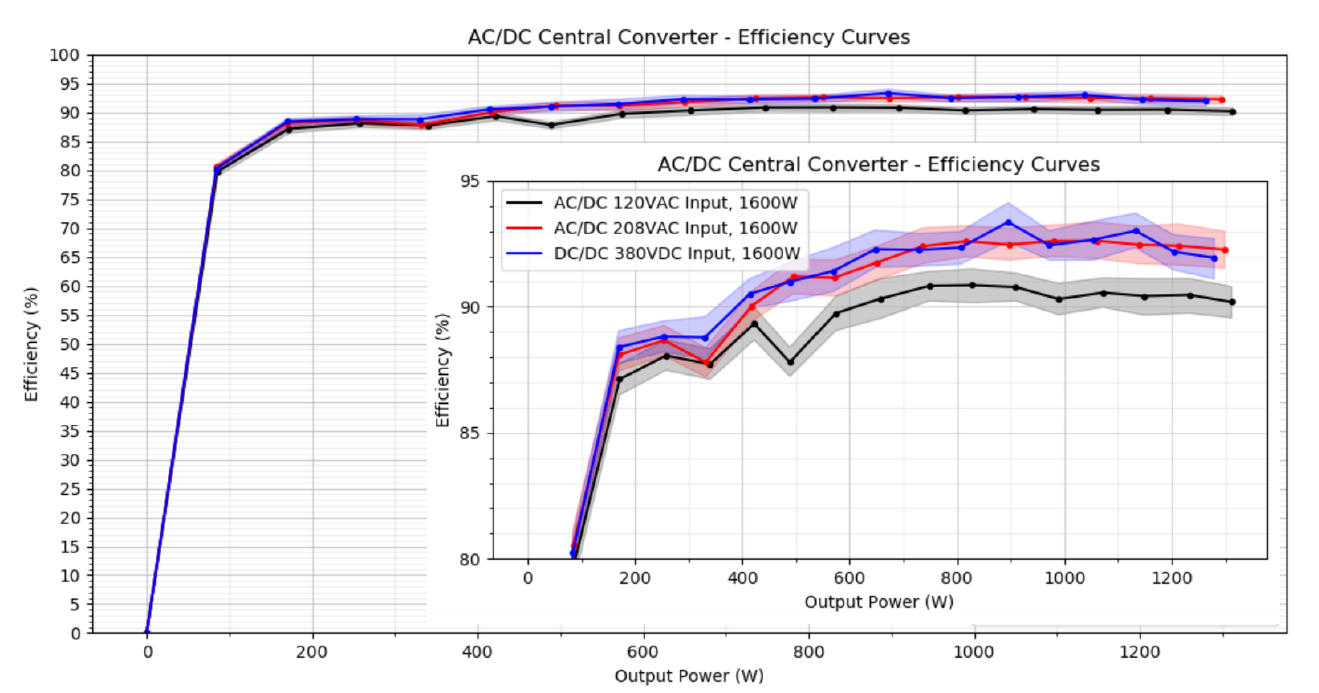
Figure 10. CC Efficiency curves at 120 V AC , 208 V AC , and 380 V DC , with respective uncertainties. The outer chart summarizes the full test range. Inset chart focuses on the area with loads of 100 W or higher. The performance at 208 V AC and 380 V DC present similar efficiencies, while the efficiency at 120 V AC is